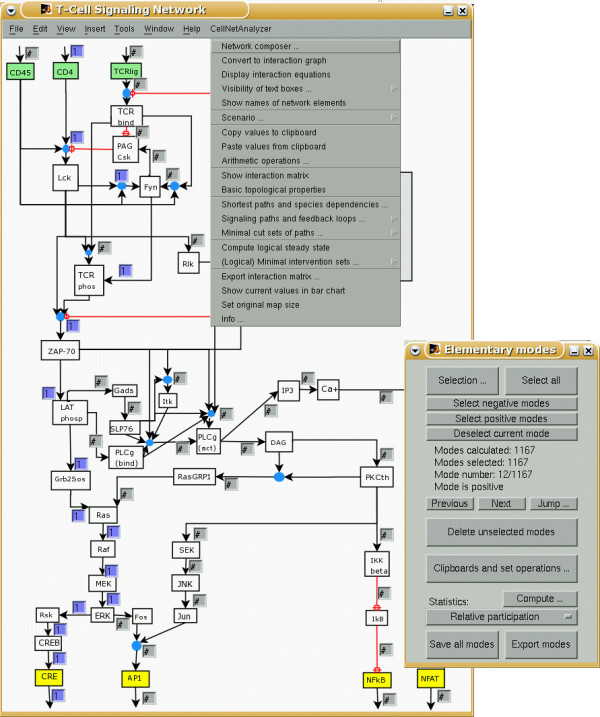
Example of an interactive network map in CellNetAnalyzer, here from a signal-flow network related to signalling pathways in T-cells. The blue text boxes display a signalling path from the receptor CD4 to the transcription factor CRE. The menu of CellNetAnalyzer (here for signal-flow networks) and the control panel for elementary modes/signalling paths are also shown.